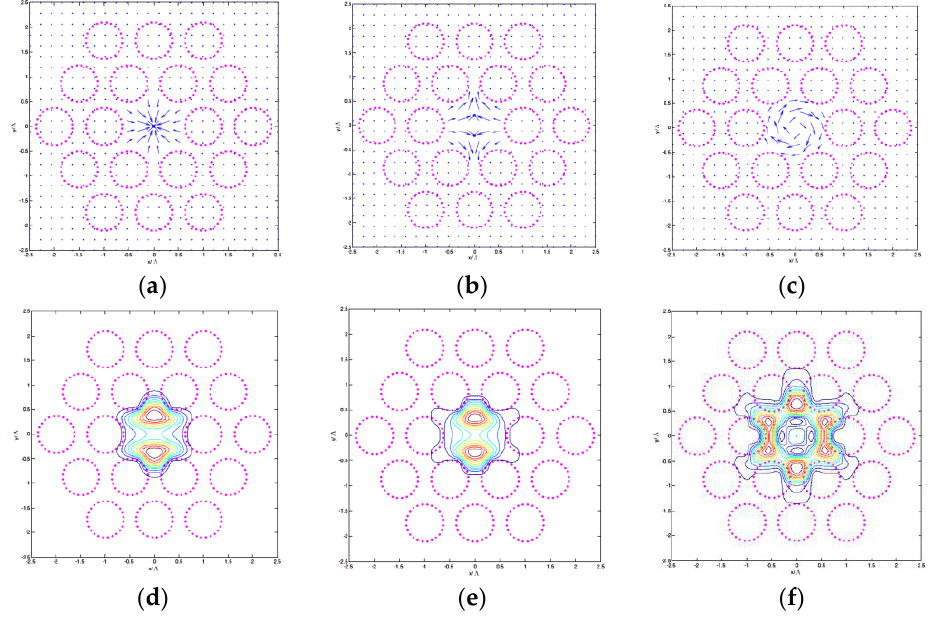
Figure 2. Transverse magnetic-field vector distributions of the real part of ( a ) TE 01 , ( b ) HE 21 , and ( c ) TM 01 modes (second-order mode) for the PCF. Field intensity distribution of the imaginary part of ( d ) TE 01 , ( e ) HE 21 , and ( f ) TM 01 modes for the PCF with 2 air-hole rings (18 air-holes).